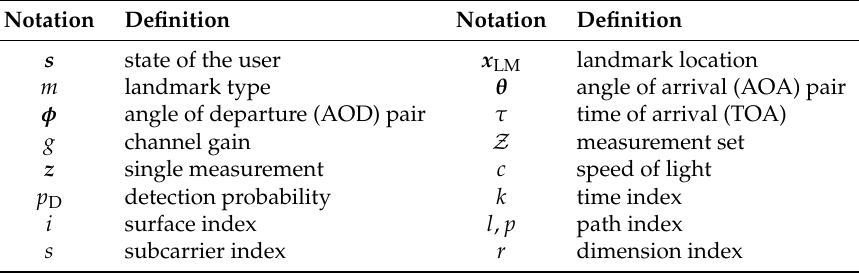
Table 1. Notations of important